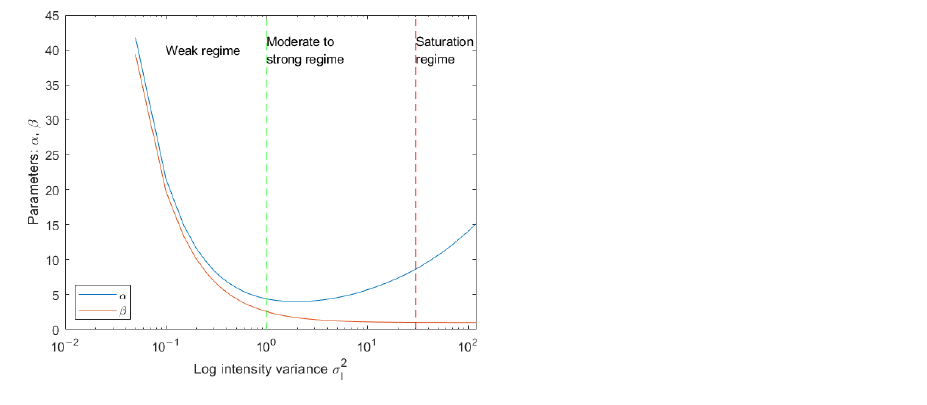
 values, l  values, respectively. l